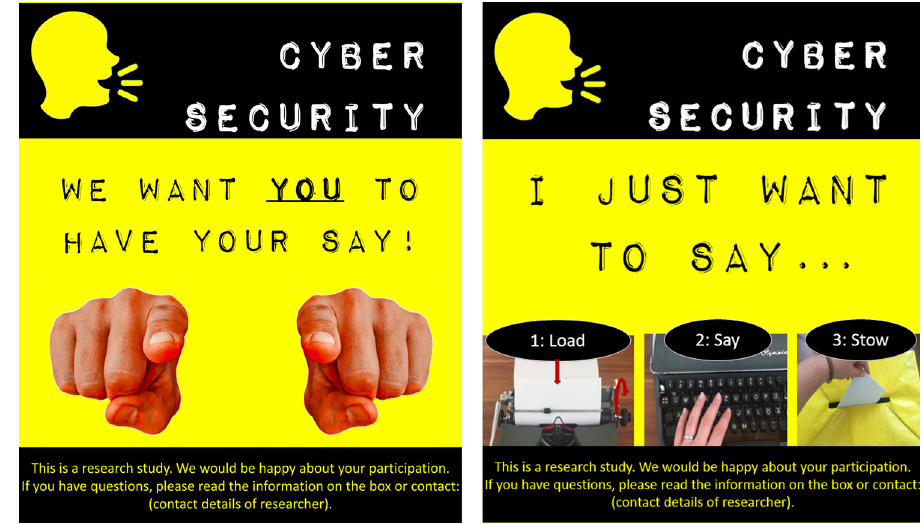
Fig. 6 The attention-catching and instruction posters used in the pilot study, translated to English from German.